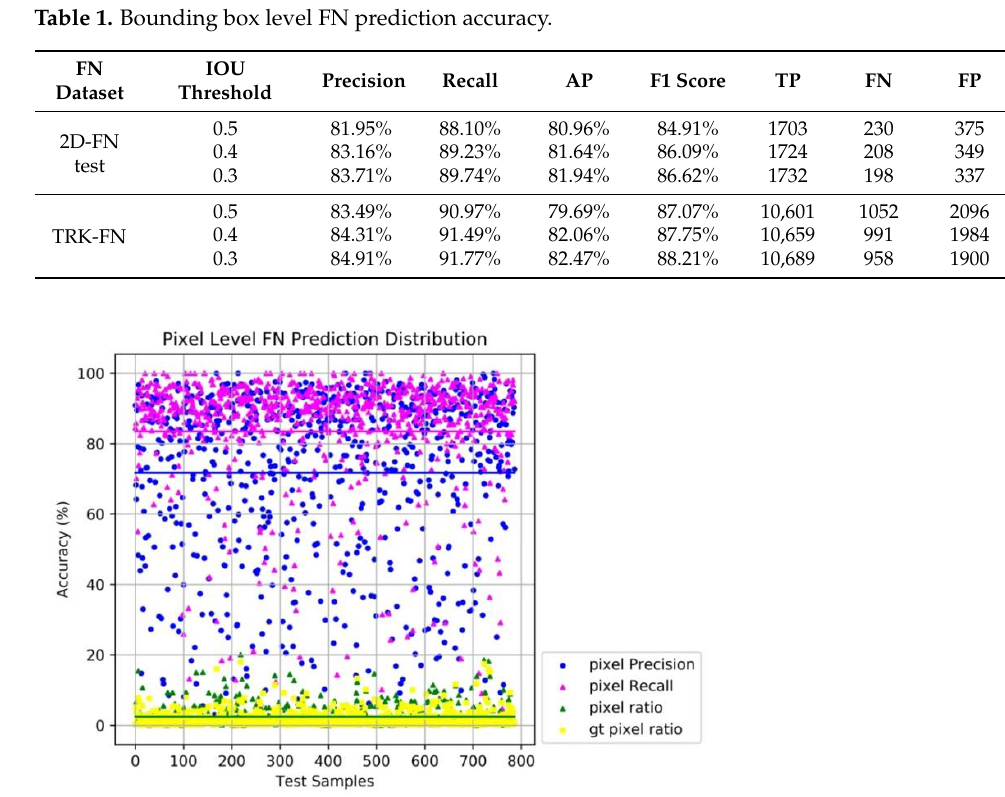
( b ) Figure 8. PR Curves on different datasets. ( a ) PR Curves on the 2D-FN test dataset. ( b ) PR Curves on the TRK-FN dataset. PR Curves of the FN prediction performance are labeled as FN, the object detection performance of the given object de- tector are labeled as SSD, and the object detection performance when taking FN predictions into consideration are labeled as SSD+FN. Therefore, the quantitative improvements to the object detection performance can be visualized by comparing the SSD+FN PR Curve with the SSD curve. The detailed evaluation results are listed in Table 2, the results show that our frame- work improves the detection performance by more than 50% in AP, and correctly predicts